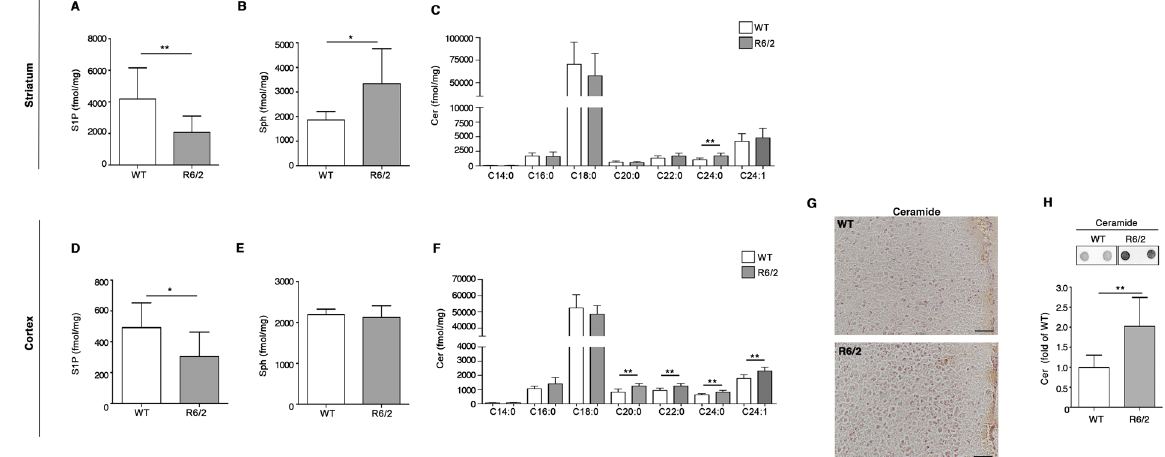
Figure 5. Levels of essential sphingolipids are defective in brain tissues from R6/2 mice. Lipidomic analysis by LC-MS/MS of S1P, Sph and Cer content in striatal (A–C) and cortical (D,F) tissues from manifest (11 week old) R6/2 mice and WT littermates. Values are represented as mean ± SD. N = 7–10 for each group of mice. * p < 0.05; ** p < 0.001; *** p < 0.0001 (Unpaired t-test). Representative immunohistochemical micrograph ( G ) and dot blotting and densitometric analysis ( H ) of Cer content in the cortex of manifest R6/2 mice and WT littermates. Scale bar in each micrograph represents 100 µ m. Data are represented as mean ± SD. N = 5 for each group of mice. ** p < 0.001 (Unpaired t-test).